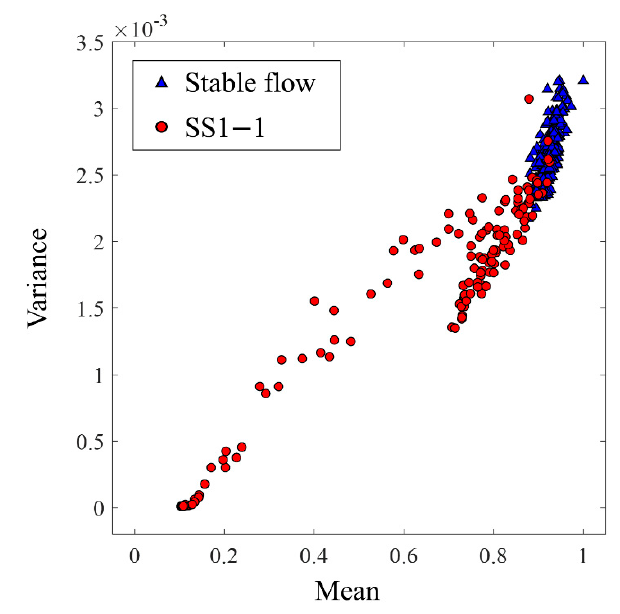
Figure 8. Distribution of mean and variance parameters for stable flow ( u SW = 0.26 m / s, u SG = 1.48 m / s) and SS1-1 ( u SW = 0.09 m / s, u SG = 0.59 m / s). The red circle markers represent SS1-1 and the blue triangle markers represent stable flow.